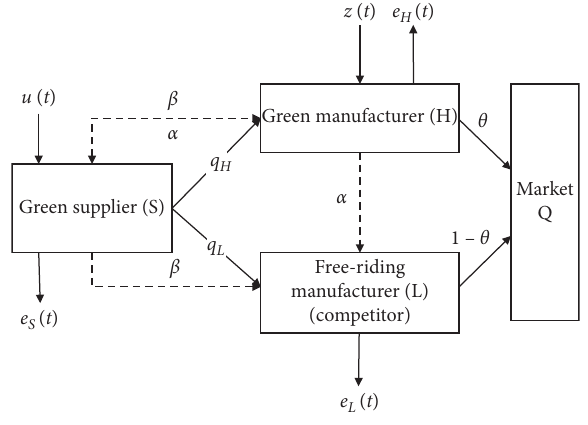
Figure 1: Supply chain